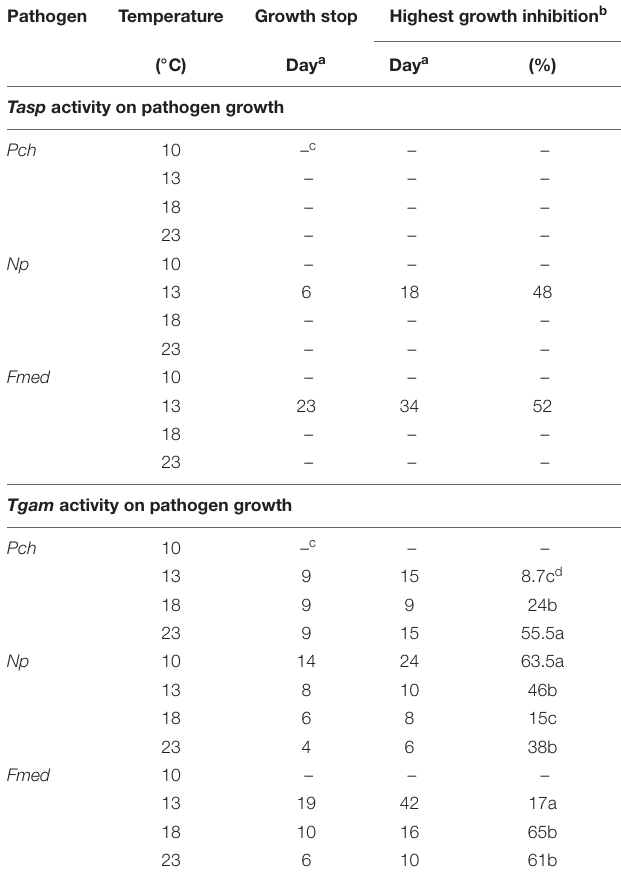
TABLE 3 | Indirect activity of T. asperellum ( Tasp ) and T. gamsii ( Tgam ) strains in stopping or reducing the growth of the pathogen colony in dual culture